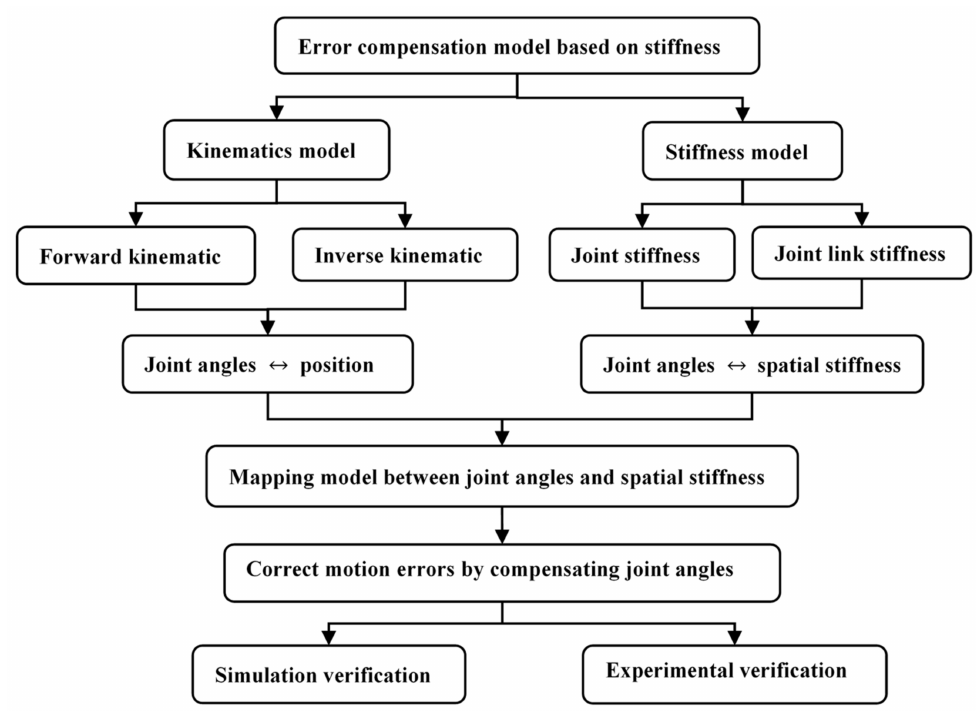
Figure 1. Schematic of the proposed